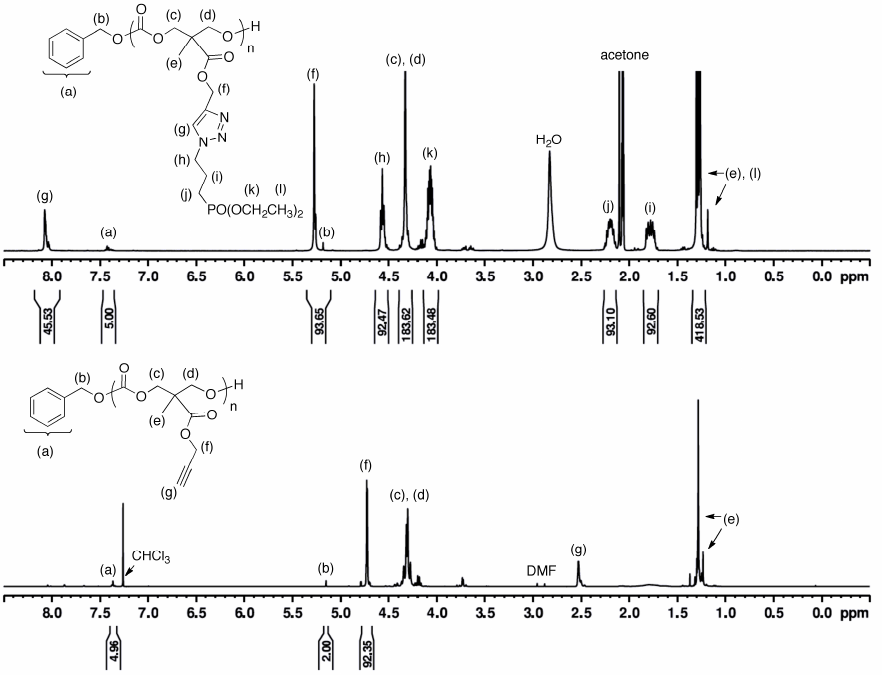
Figure 6. Overlaid 1 H NMR spectra of poly(MPC) 46 in CDCl 3 before and after the “click” reaction with azido-phosphonate in acetone D 6